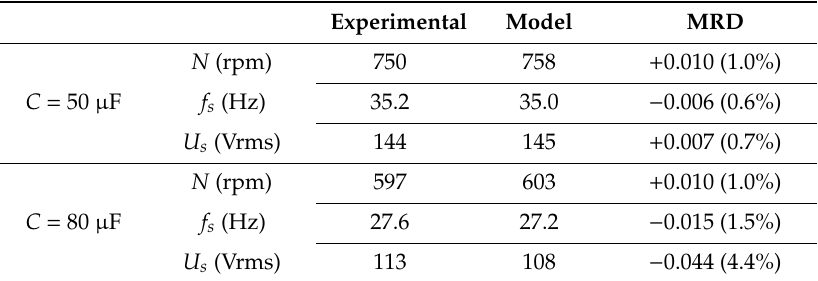
Table 3. Experimental and model steady-state values after the excitation process. Experimental